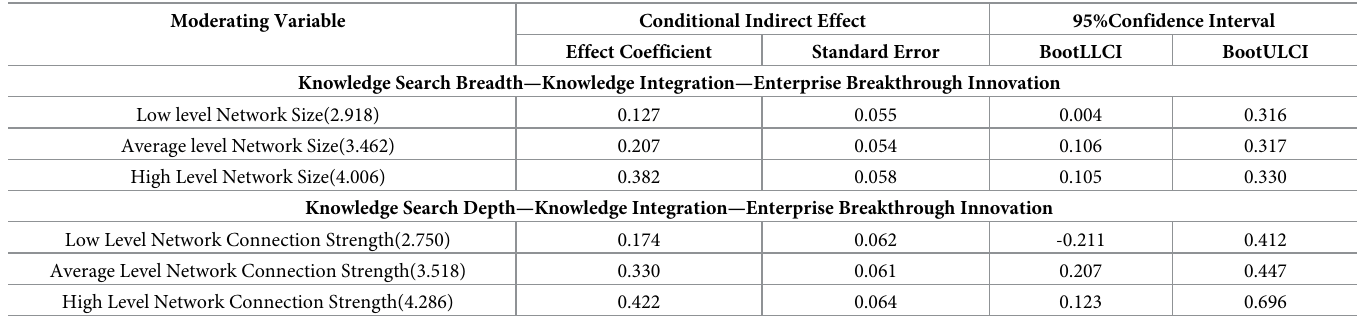
Table 9. The moderating mediating effect